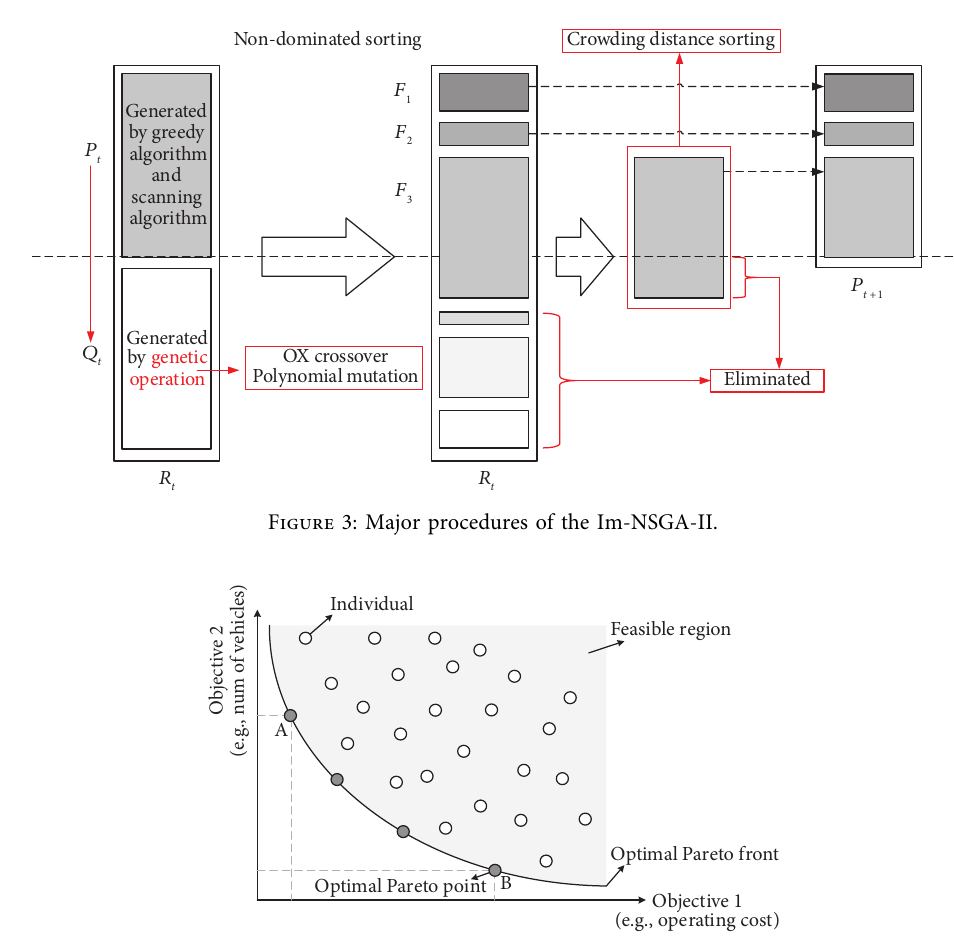
Figure 4: Pareto solutions of the multiobjective optimization